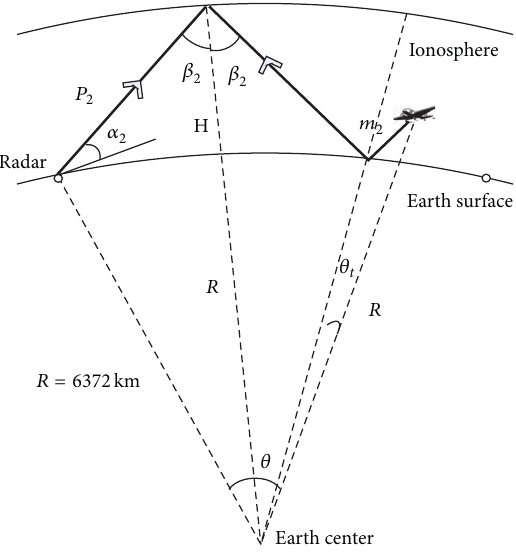
Figure 6: Path II in the earth curvature